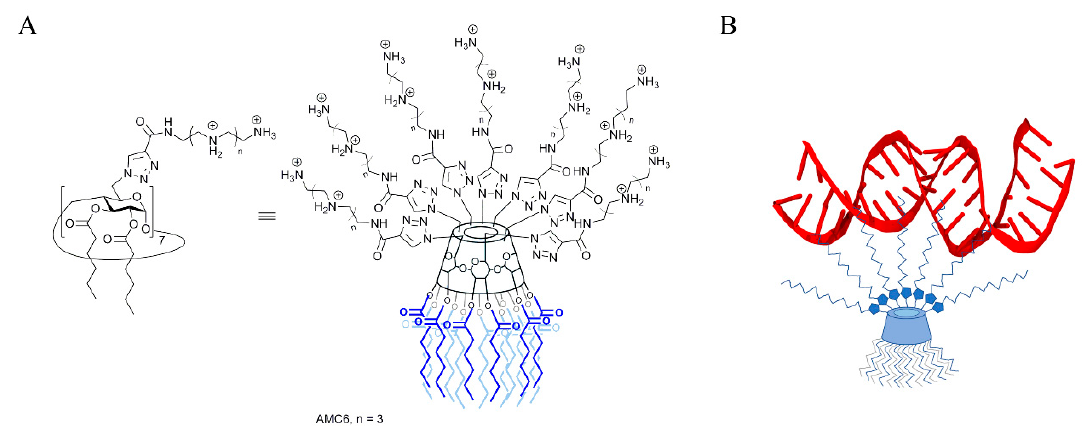
Figure 1. ( A ) Chemical structure of the polycationic amphiphilic β -cyclodextrin derivative AMC6; ( B ) Scheme showing siRNA binding to an AMC6 molecule.